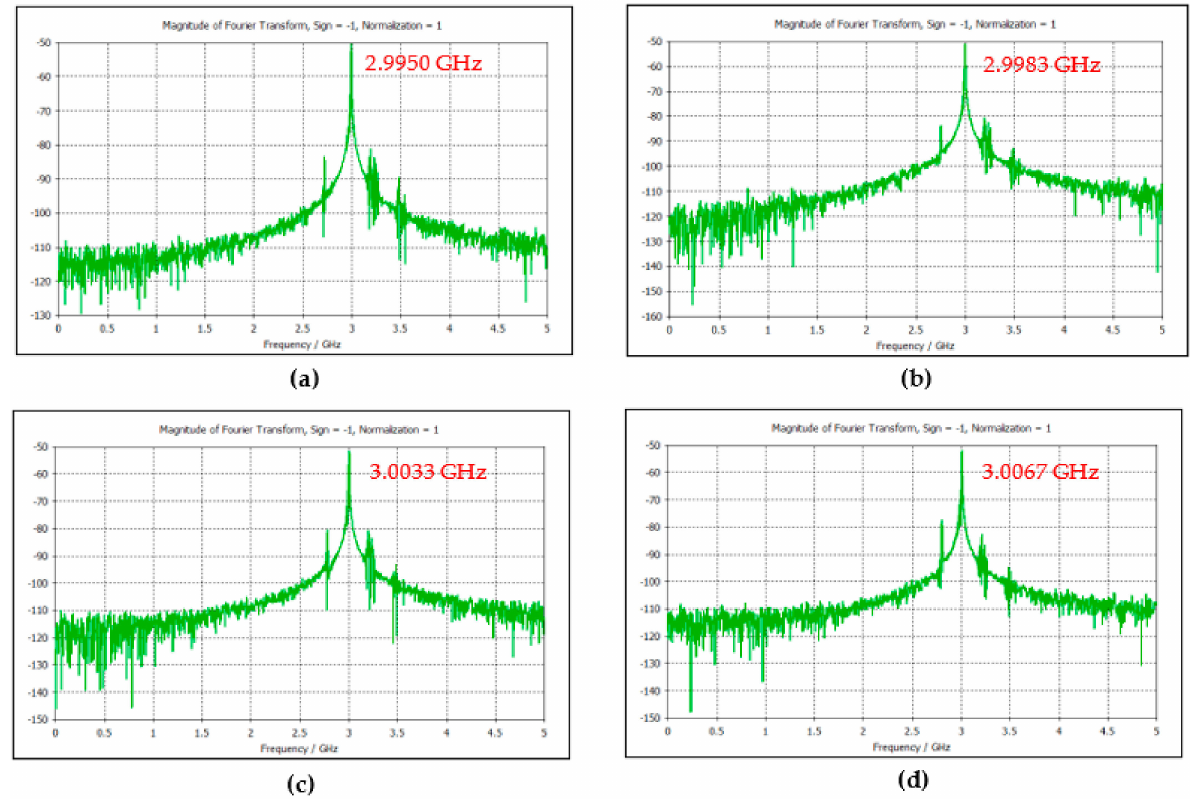
Figure 18. The results of the resonant frequency position for each tuner slot distance: ( a ) 3.22 mm; ( b ) 3.97 mm; ( c ) 5.22 mm; ( d ) 8.22 mm.